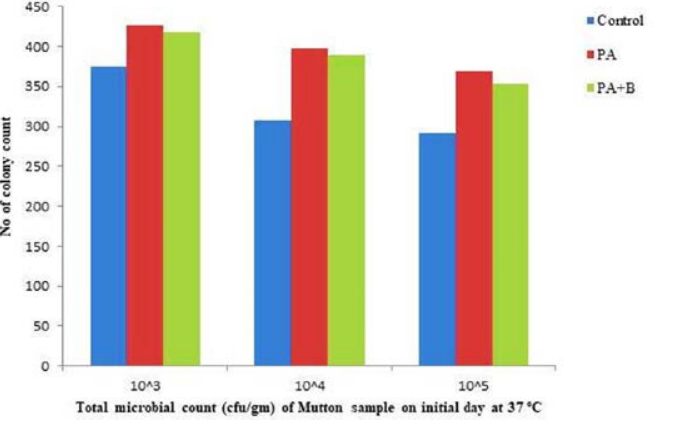
Fig. 2.6. Total microbial count of Mutton meat sample treated with strain and phage on Initial